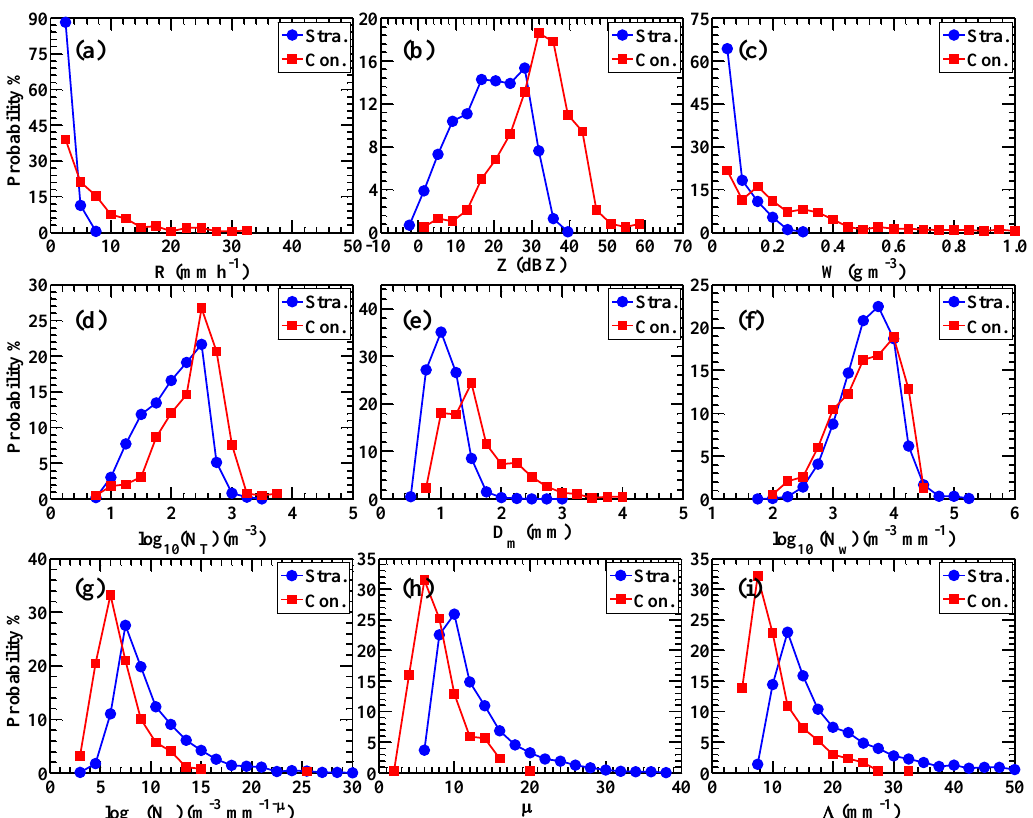
Figure 6. Boxplots of the DSDs for the stratiform ( a ) and convective ( b ) samples. D and N(D) are the raindrop diameter class and number concentration, respectively. The meaning of the boxplot is described in the caption of Figure 4.